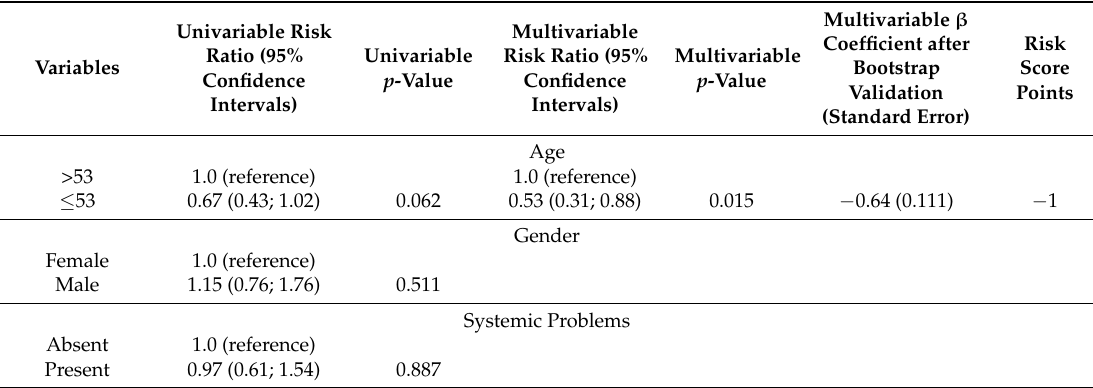
Table 2. Univariable and multivariable risk ratio estimates, multivariable beta coefficients, and risk score points for the prediction of